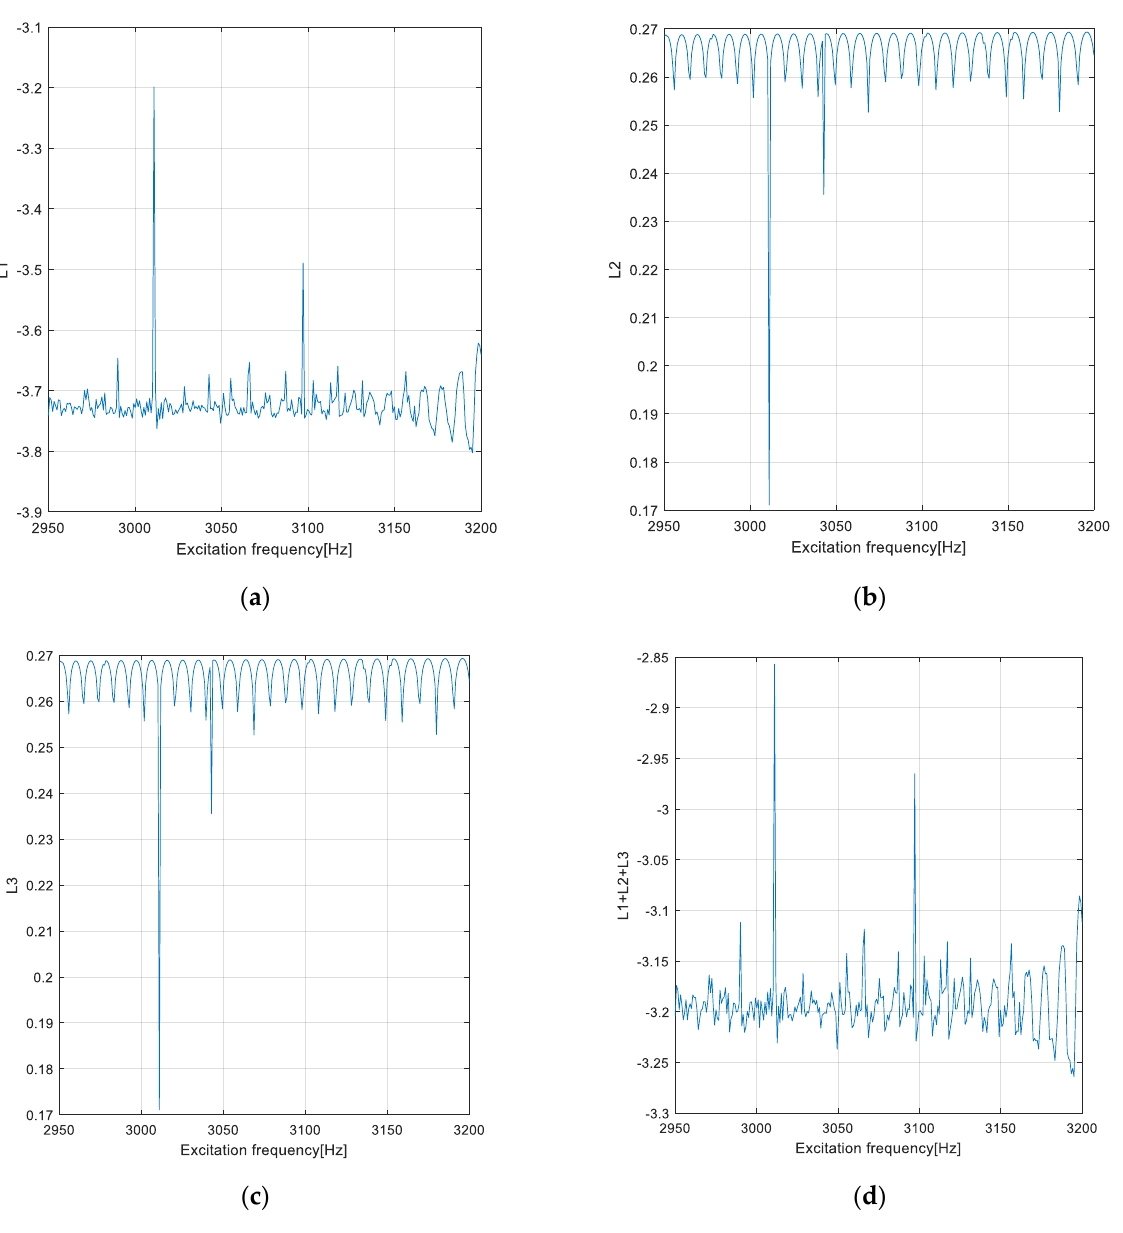
Figure 17. Lyapunov exponents of NFTV for DIE1, β